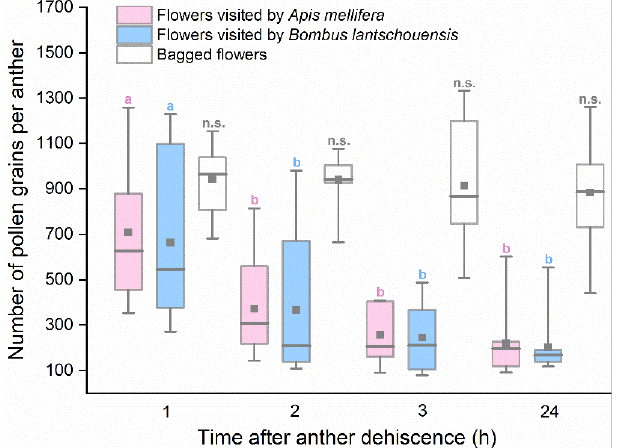
Figure 5. Number of residual pollen grains in anthers from flowers visited by Apis mellifera and Bombus lantschouensis. Different letters indicate significant differences in number of pollen grains among different time based on the Duncan test at α = 0.05. Boxes indicate quartiles with the median marked as a horizontal line and the mean marked as a dot.